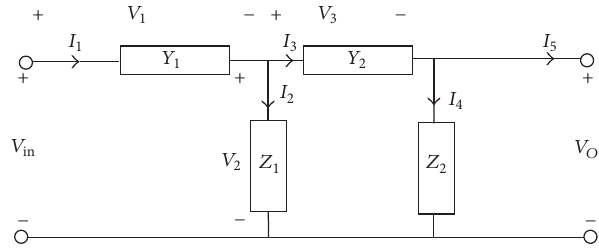
Figure 4: The ladder of Figure 3 with admittance in series arm and impedance in shunt arm.